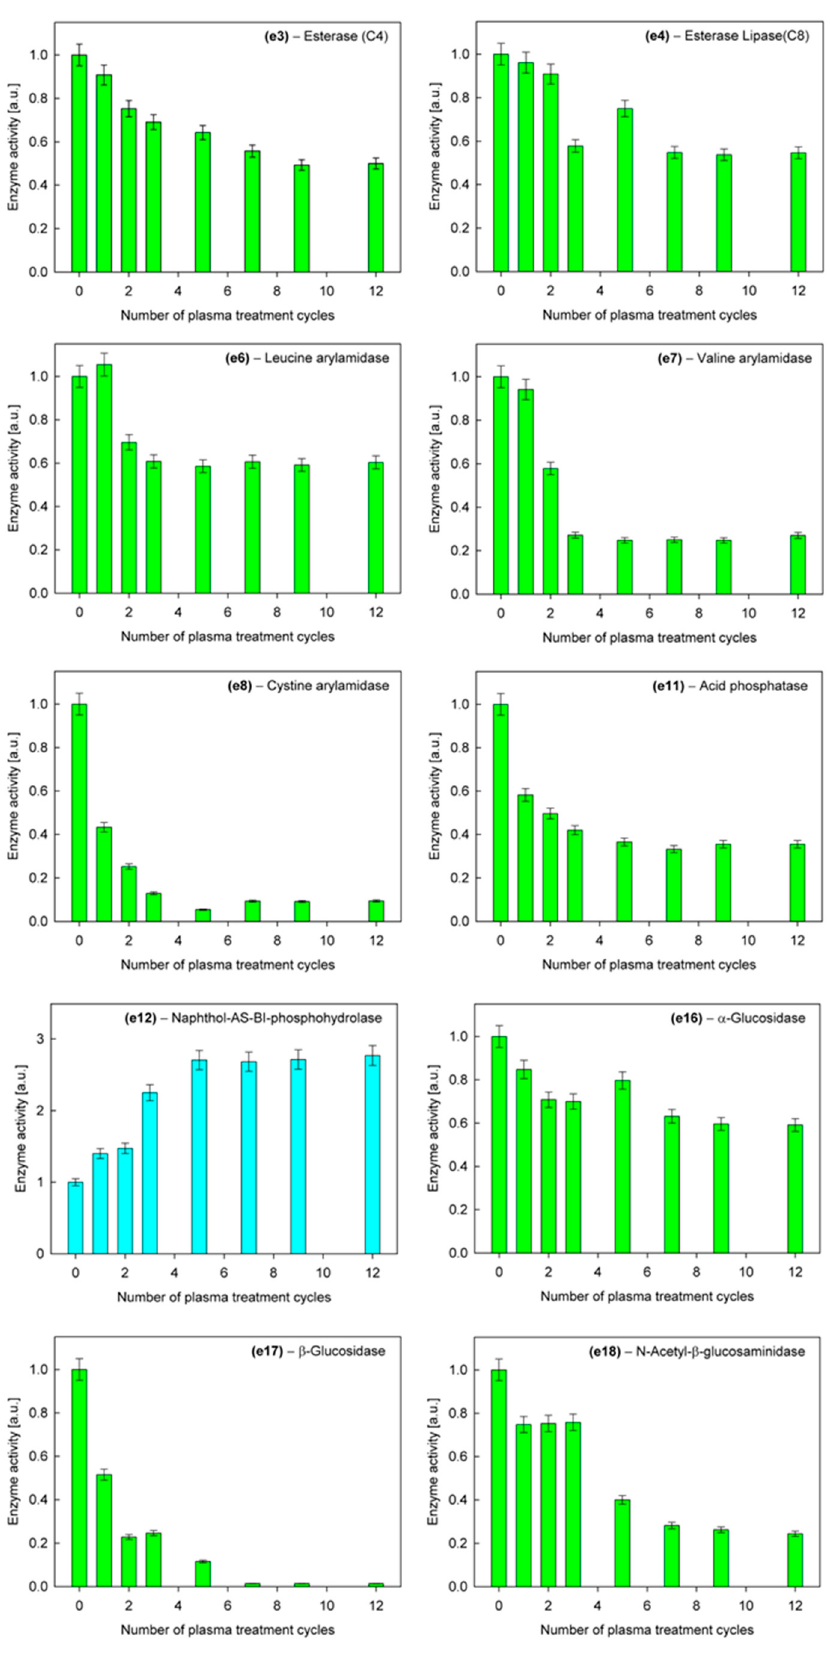
Figure 3. Activities of hydrolytic enzymes for C. albicans as a function of the number of plasma cycles.